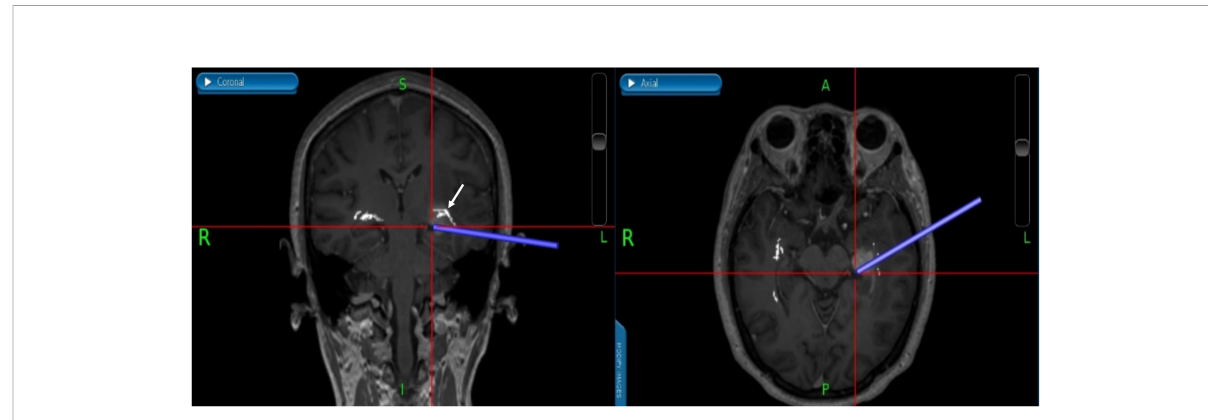
FIGURE 7 (Patient No.12) We used neuronavigation to avoid damage to the brain stem and the real time neuronavigation imaging showed that gross total resection was performed without any injuries of the OpR. The white arrow indicates the OpR. (OpR: optic